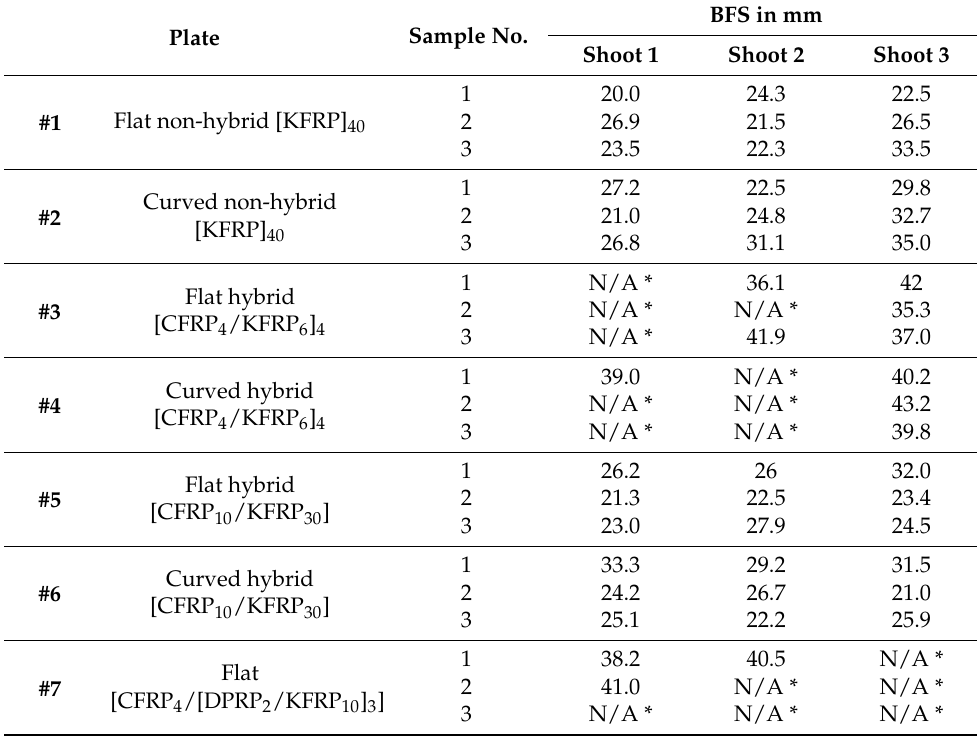
Table 4. Results of ballistic tested body armor plates (BFS: back-face